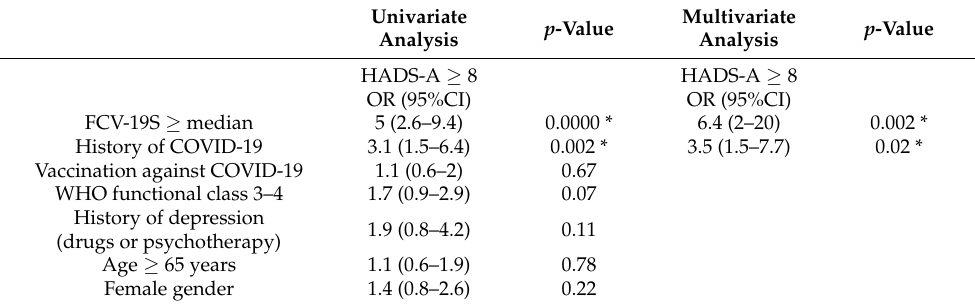
Table 4. Impact of different factors on anxiety in the HADS scale (HADS-A ≥ 8): Results of the univariate and multivariate logistic regression analysis.